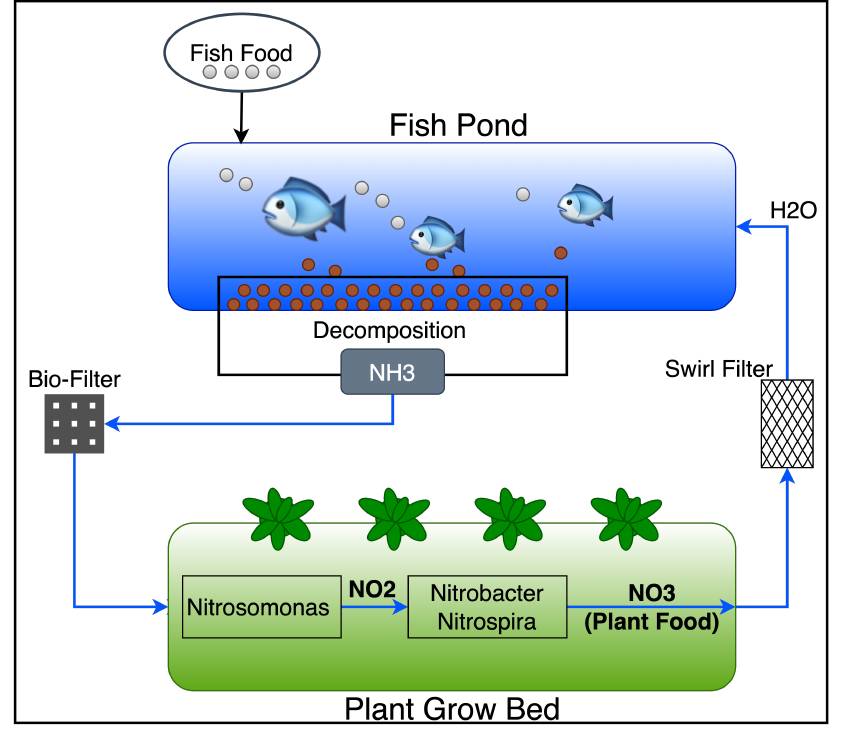
Figure 1. Aquaponics